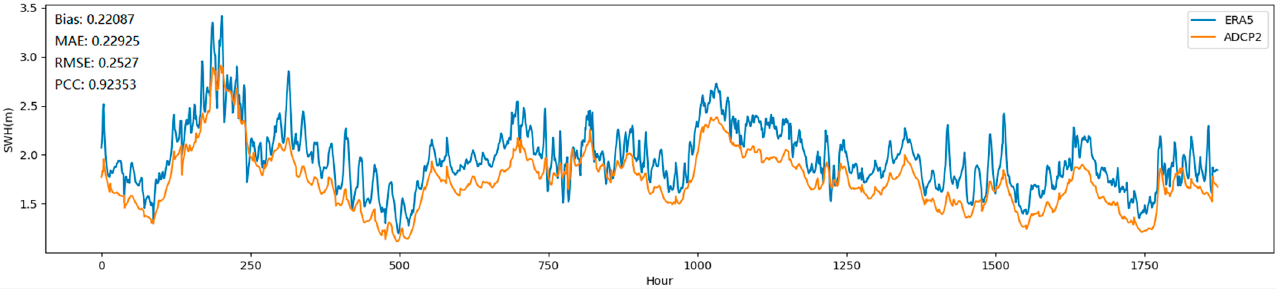
Figure 3. Comparison of the ADCP2-observed SWH and interpolated SWH from ERA5. Table 1. Port-entrance wave parameters required to generate the in-port SWH dataset using the calibrated SWASH model.